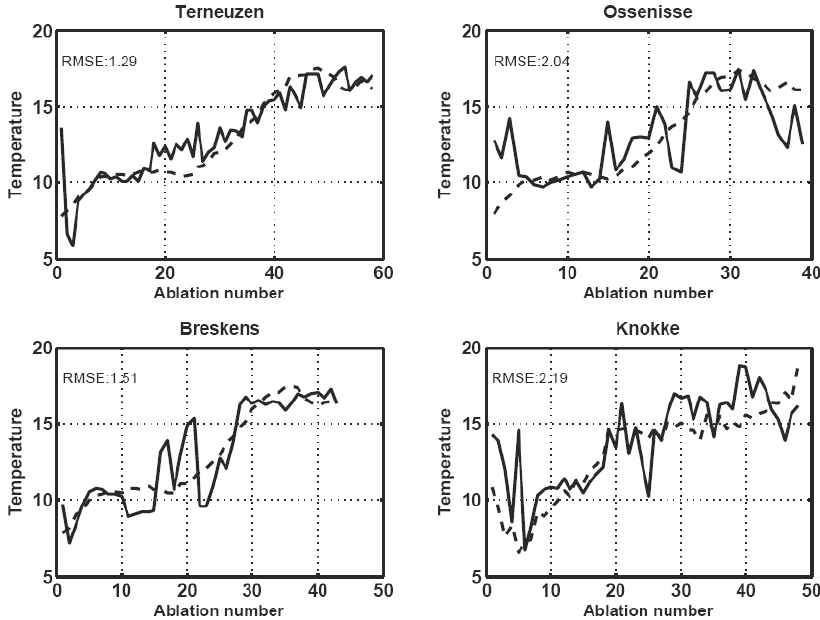
Fig. 6. Measured water temperature (dashed line) and reconstructed water temperature (solid line) obtained by the four-proxy WDMR model trained on Terneuzen data set and tested on a single validation shell from Terneuzen, Breskens, Ossenisse and